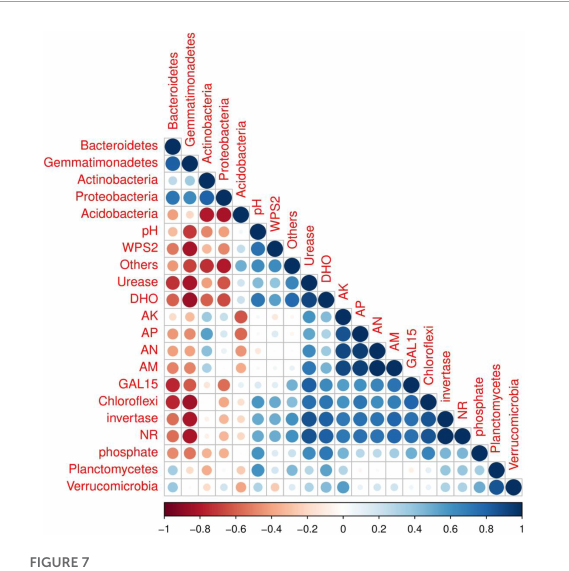
FIGURE7 Correlation analysis of soil microbial abundance, soil characteristics, and soil enzyme activity among